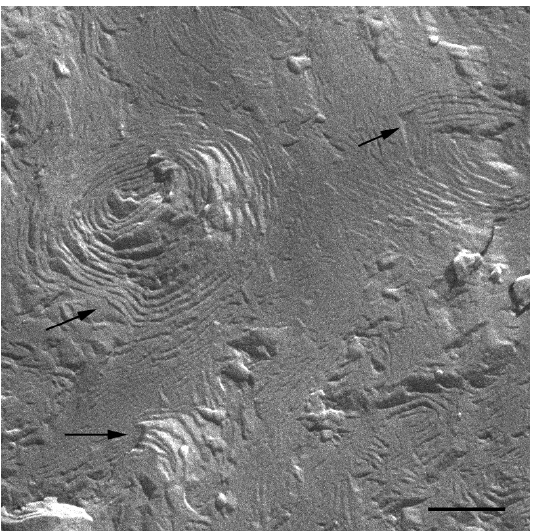
Figure 5. Electron micrograph image of the S-q3.5 system at 40 °C showing stacked bilayer sheets (arrows). Bar = 500